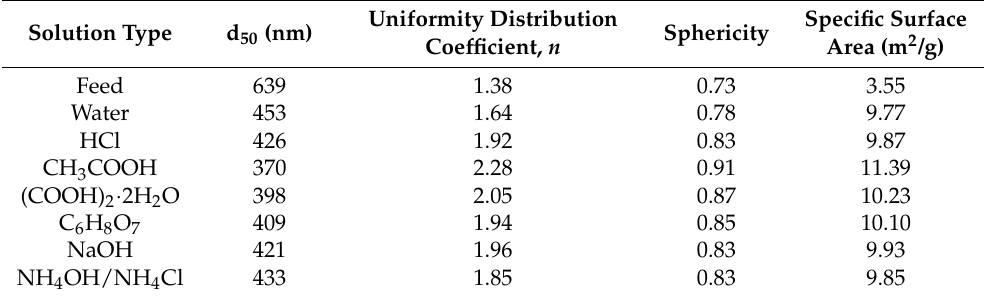
Figure 1. The PSD of ZnO particles ground in water or various other chemical solutions at a concentration of 0.010 mol/L for 30 min. ( a ) the interval mass distribution of ZnO particles; ( b ) the cumulative mass distribution of ZnO particles. Table 2. The d 50 , n , sphericity and specific surface area of ZnO particles ground for 30 min in water or one of various solutions at a concentration of 0.010